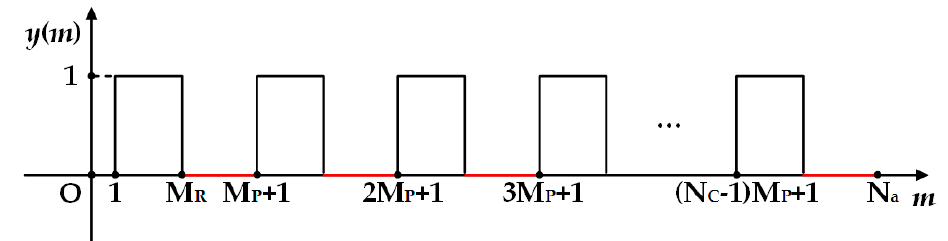
Figure 7. Demonstration of rectangular pulse sequence.